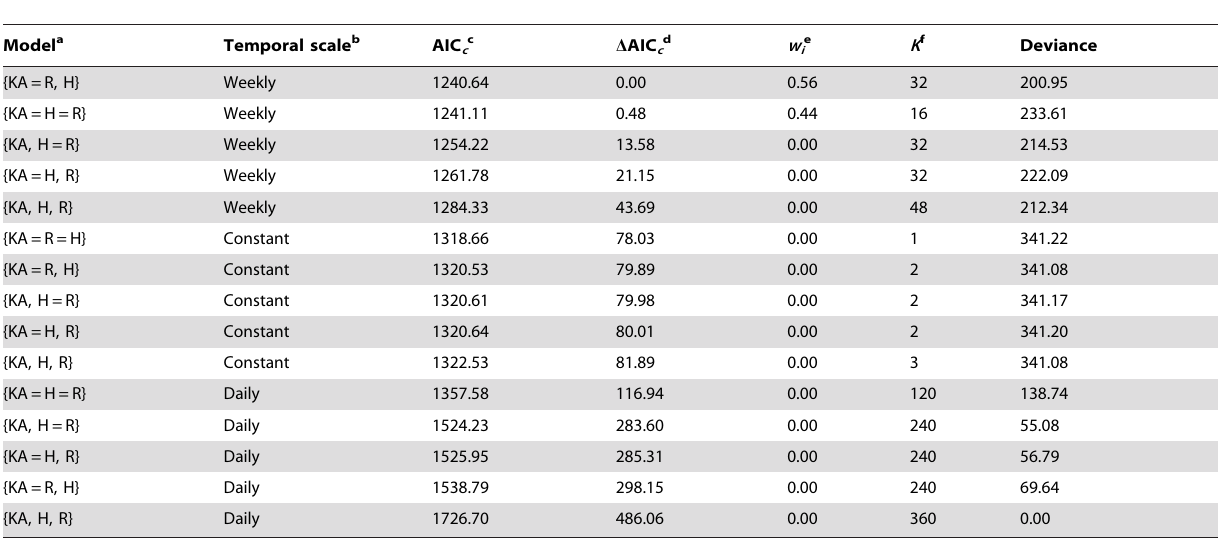
Models compared and contrasted survival rates among groups and time-dependency. a KA=known-age newborn, R=Robinette [21], and H=Haskell [17] neonatal-age model. b Temporal scale represents constant, daily, or weekly survival among intervals. c Akaike’s Information Criterion corrected for small sample size [55]. d Difference in the AIC c value of the top-ranked model and that of the model under consideration. e Akaike weight [55].